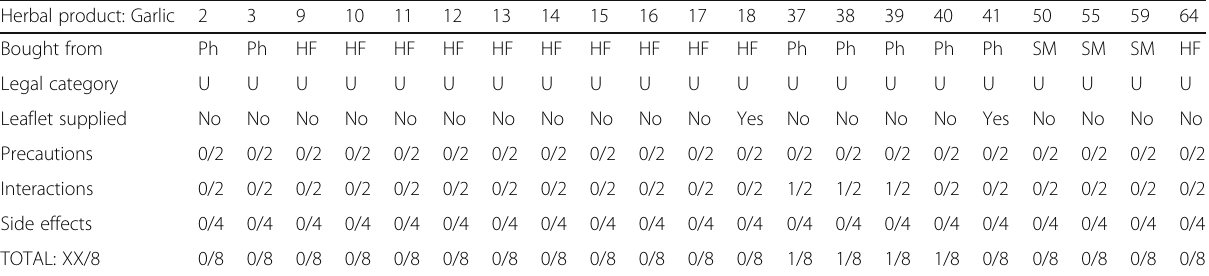
Herbal product: Garlic